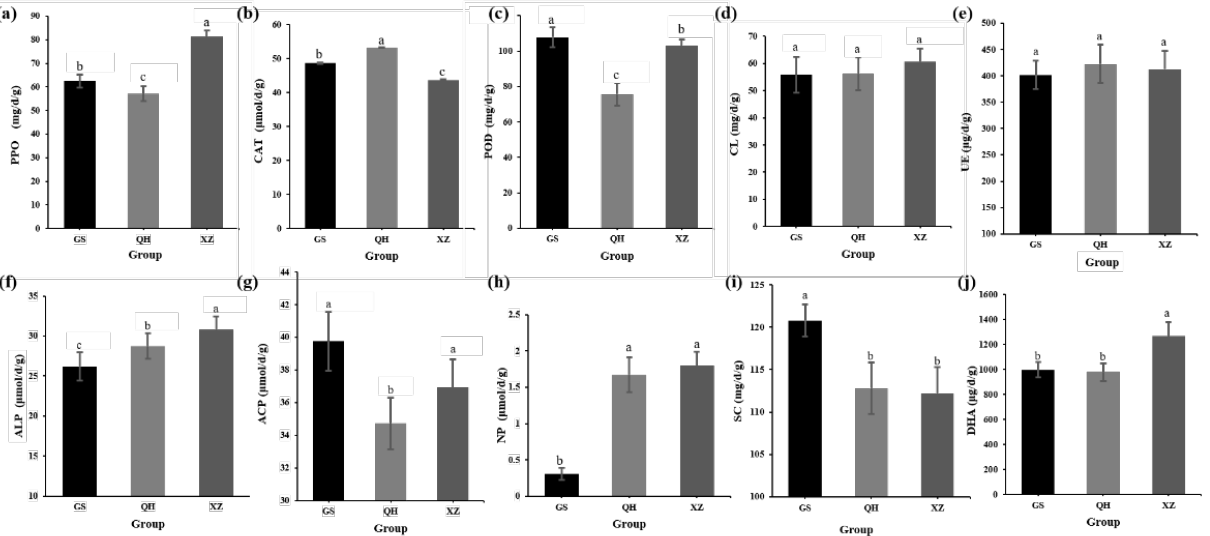
Figure 2. Changes in soil enzymatic activity. Polyphenol oxidase (PPO) ( a ), catalase (CAT) ( b ), peroxidase (POD) ( c ), cellulase (CL) ( d ), urease (UE) ( e ), alkaline phosphatase (ALP) ( f ), acid phosphatase (ACP) ( g ), neutral phosphatase (NP) ( h ), soil sucrase (SC) ( i ), dehydrogenase (DHA) ( j ). The samples were from Tibet (Group XZ), Qinghai (Group QH), Gansu (Group GS). Different lowercase letters (a, b, c) indicate a significant difference at p ≤ 0.05.